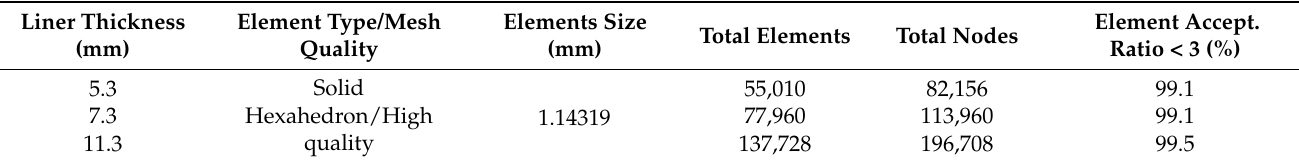
Table 1. Mesh liner parameters for